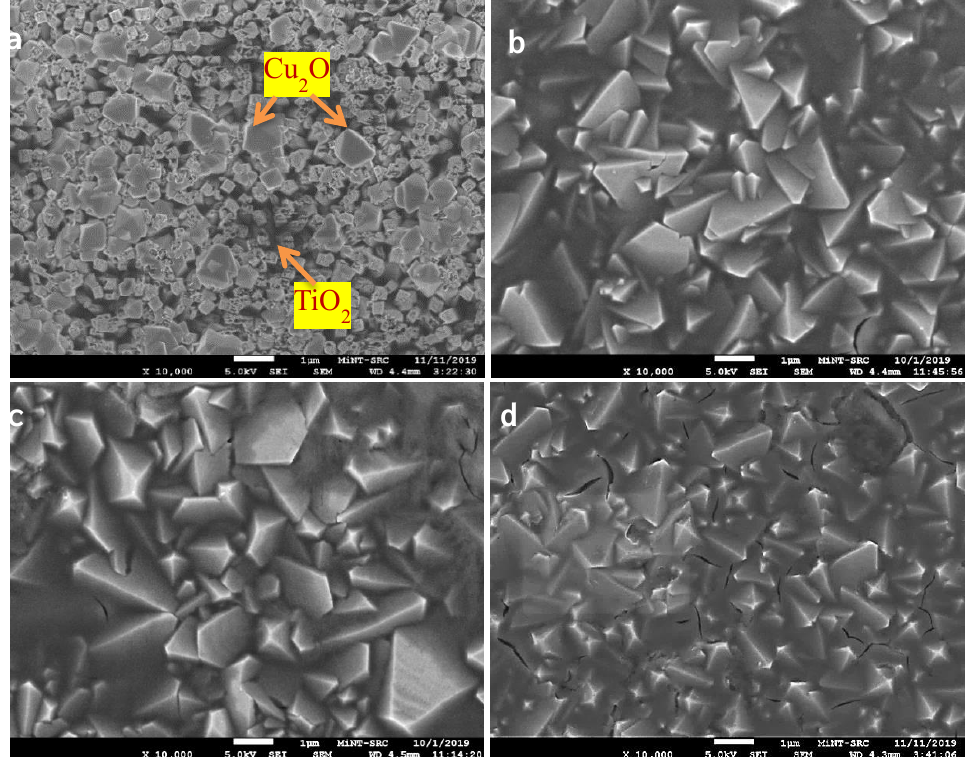
Figure 3. FE-SEM images of the Cu2O deposited at (a) 30, (b) 60, (c) 90 and (d) 120 minutes on TiO2 nanorods sample under x 10,000 magnification,